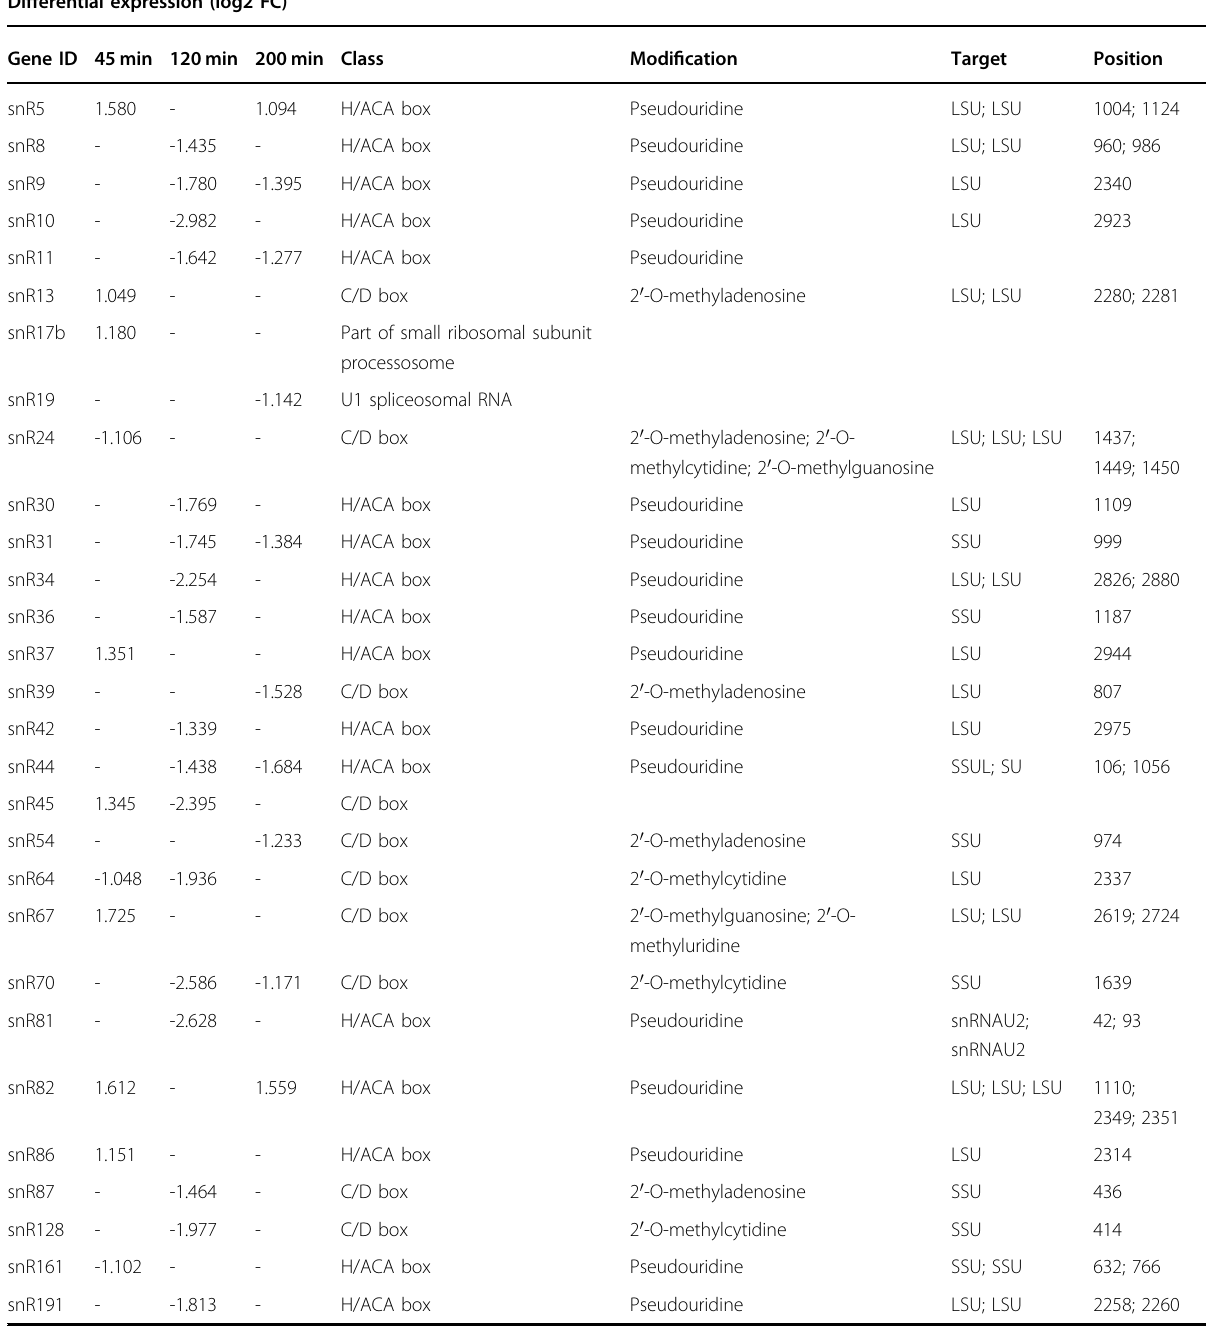
Table 1 List of signi fi cant differentially expressed snoRNAs. Differential expression (log2